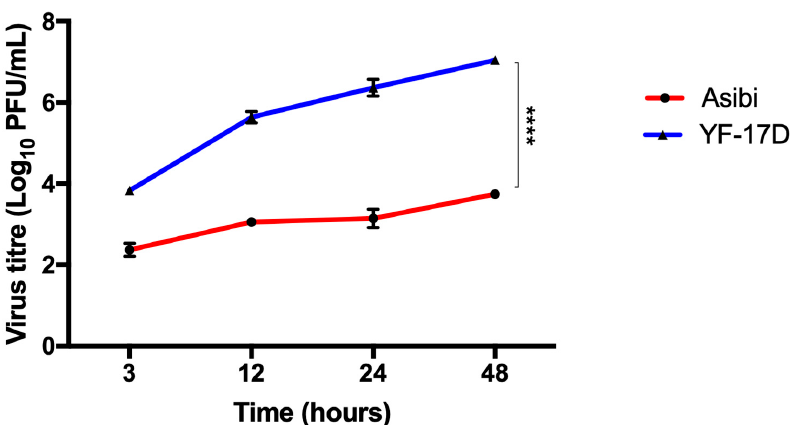
Figure 2. YF-17D infects and replicates more efficiently than Asibi strain in HeLa cells. HeLa cells were infected with Asibi or YF-17D at MOI = 1. Culture supernatants were aspirated at indicated time points and viral titre determined by plaque assay. Result is indicative of two independent experiments performed in duplicate. Data are presented as mean ± SEM. * = p ≤ 0.05, **** = p ≤ 0.0001.